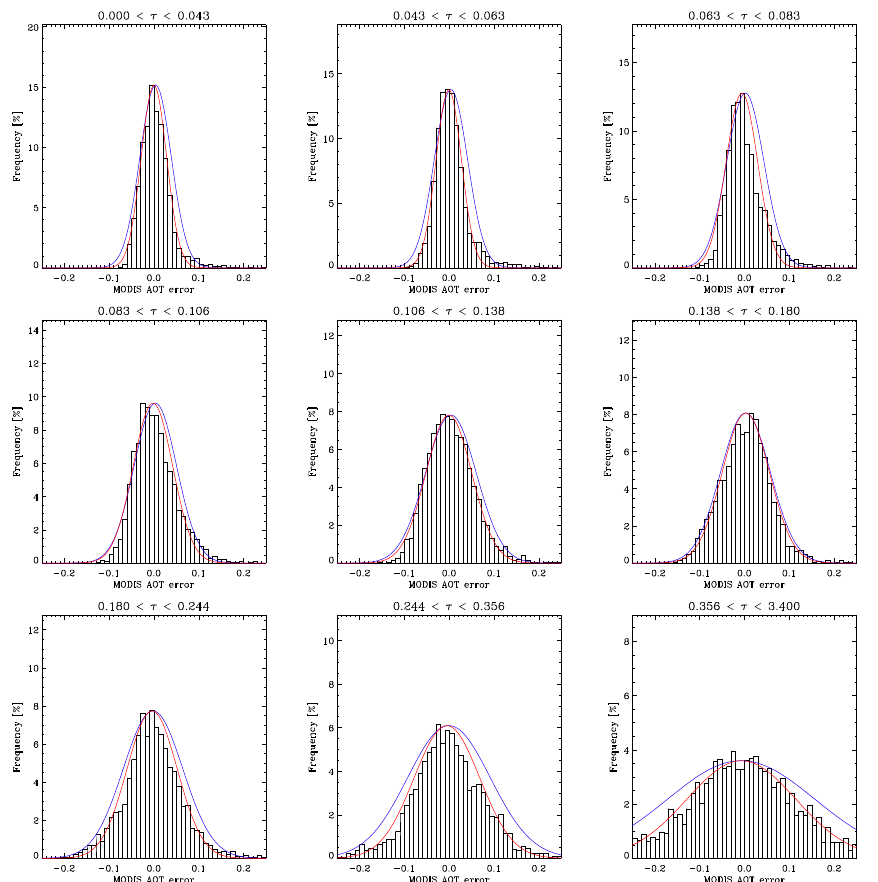
Fig. 17. Aqua AOT error distributions for the corrected observations as a function of AERONET AOT. Also shown are two Gaussian distributions that where fitted to the data, using two different methods for estimating the standard deviation. One method uses the actual standard deviation of the sample (blue), the other method uses the random error as defined in this paper (red). The random error leads to a better agreement with the actual distribution due to the presence of